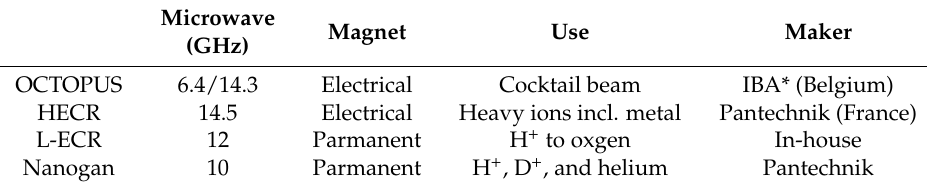
Table 2. List of the electron cyclotron resonance (ECR) ion sources.